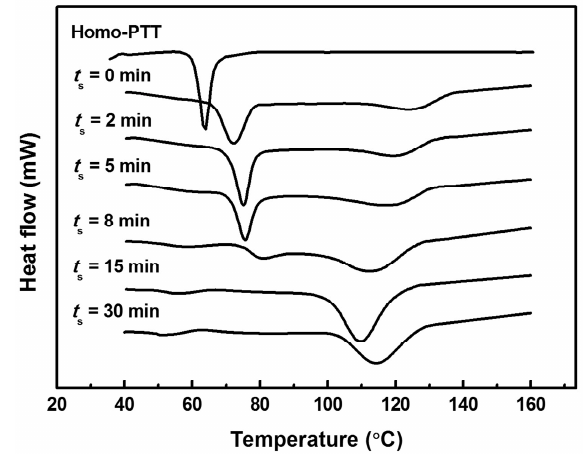
Figure 3. DSC heating thermograms of homo-PTT and blend samples. Homo-PTT was quenched after annealing at 265 °C for 5 min and blend samples were quenched after annealing at 265 °C for t s .